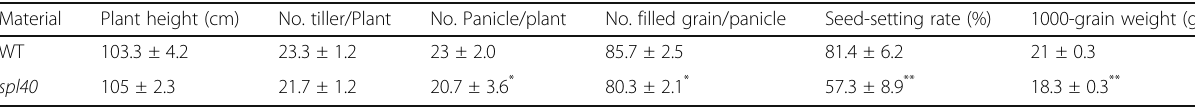
Table 1 Agronomic performance of spl40 Material